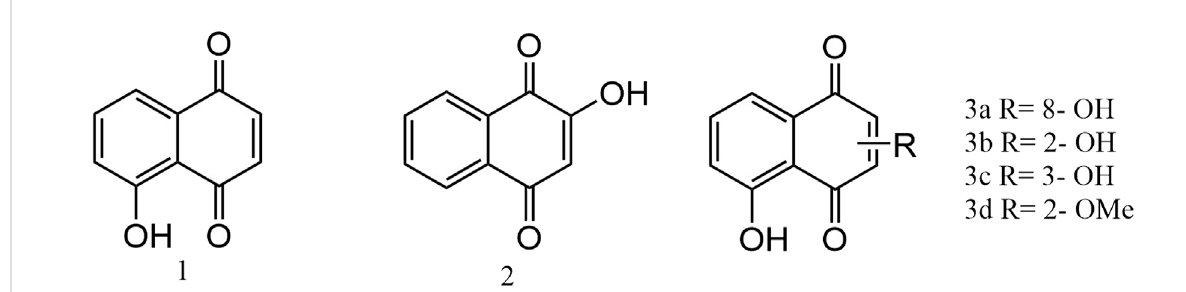
FIGURE 3 Chemical structures of anticancer compounds with juglone skeleton.